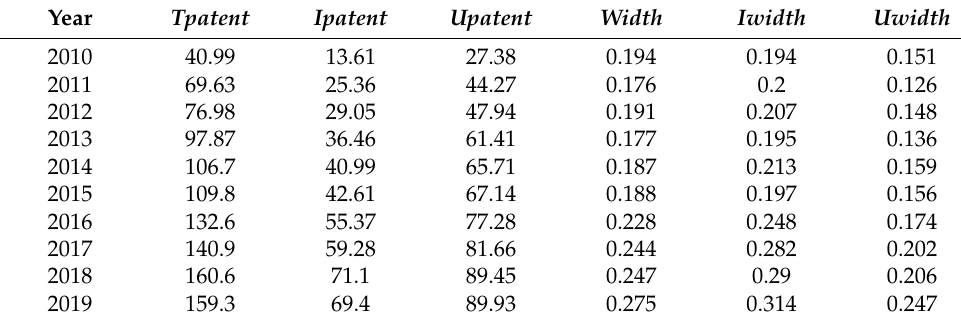
Table 3. Descriptive statistics of the dependent variables by year (mean value).